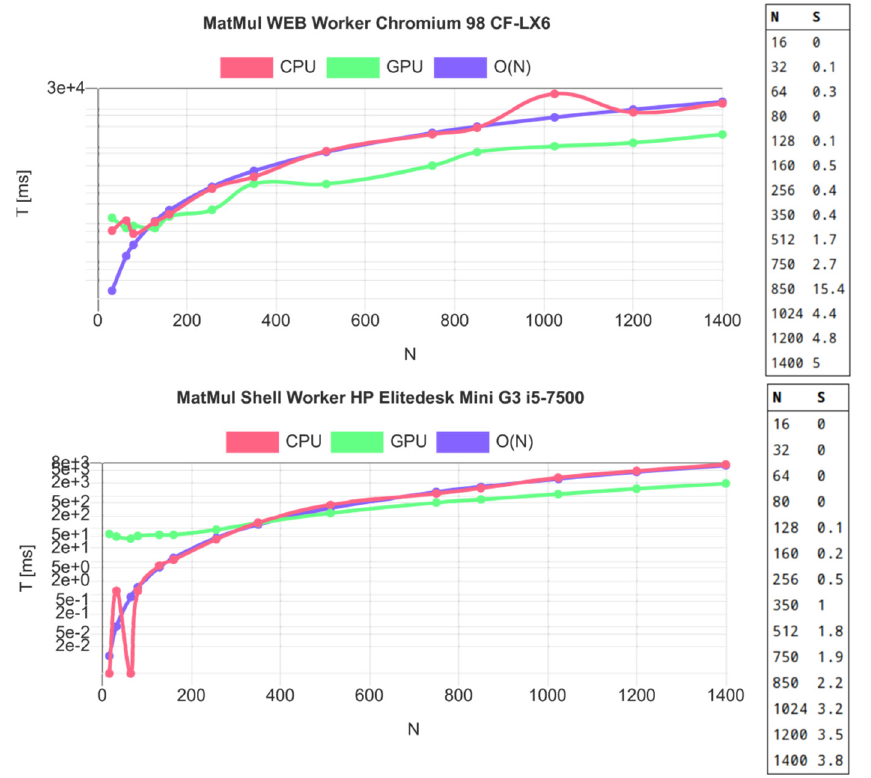
Figure 7. ( Top ) WorkBook worker/WebGL; ( bottom ) WorkShell worker/OpenGL: performance analysis of an N × N matrix multiplication, using Vanilla JS and GPU transpiled kernel functions (Integrated Intel GPU).